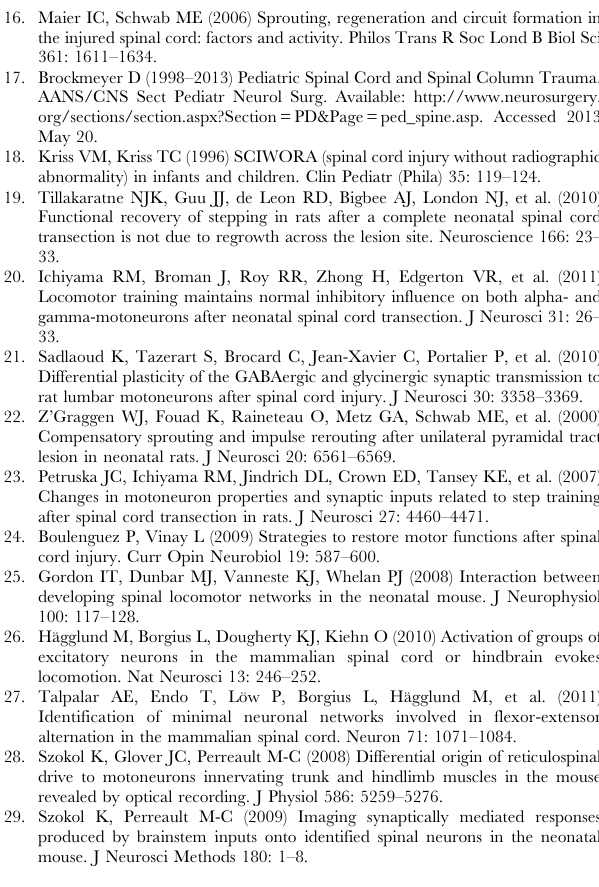
Figure S1 Distribution of retrogradely labeled spinal neurons in a single sham (black dots) and a single SCC (white dots) spinal cord 1 day after surgery/injury. Each dot represents the number of RDA-labeled neuronal profiles in a single section taken at the indicated level along the length of the spinal cord. The grey area represents the compressed region, and the red area the RDA application site. The two sets of sections were aligned using the rostral terminus of the RDA application site as zero. Note that in the SCC mouse neurons are virtually absent within the compressed region, and that there are few labeled neurons with axons descending through the compressed region to the RDA application site. Figure S2 Developmental profile of air stepping in sham control mice, and gait analysis of sham and SCC mice. (A) Kinematic assessment of the trajectories (A) and instantaneous velocities (B) of forepaws (blue traces) and hindpaws (green traces) during air stepping by sham mice at 3 times after surgery. (C and D) Gait analyses comparing sham and SCC mice 24 days after surgery/injury. (C) Representative stance durations of the 4 paws of one SCC mouse (red) and one sham control mouse (black) during voluntary walking along a track. (D) Average